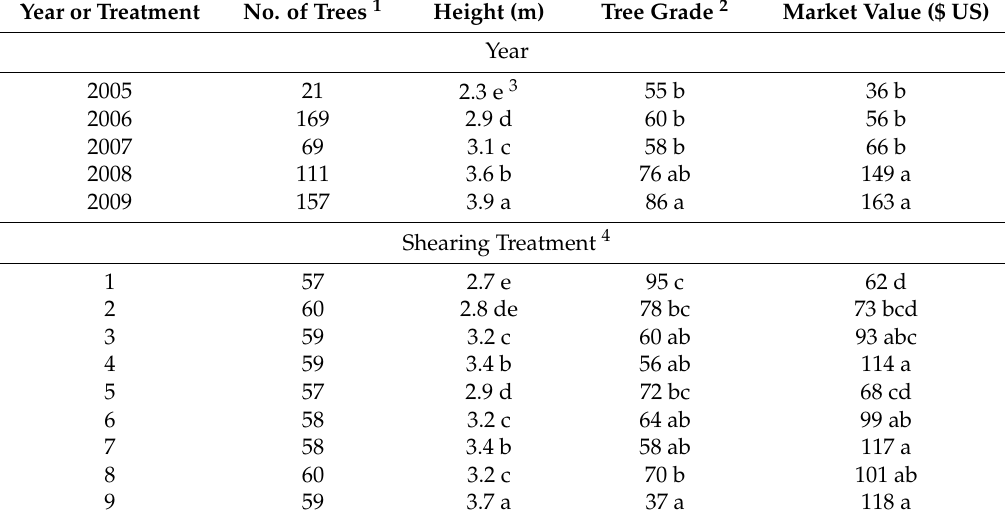
Table 2. Height, USDA grade, and market value of Fraser fir Christmas trees sheared with various leader lengths.